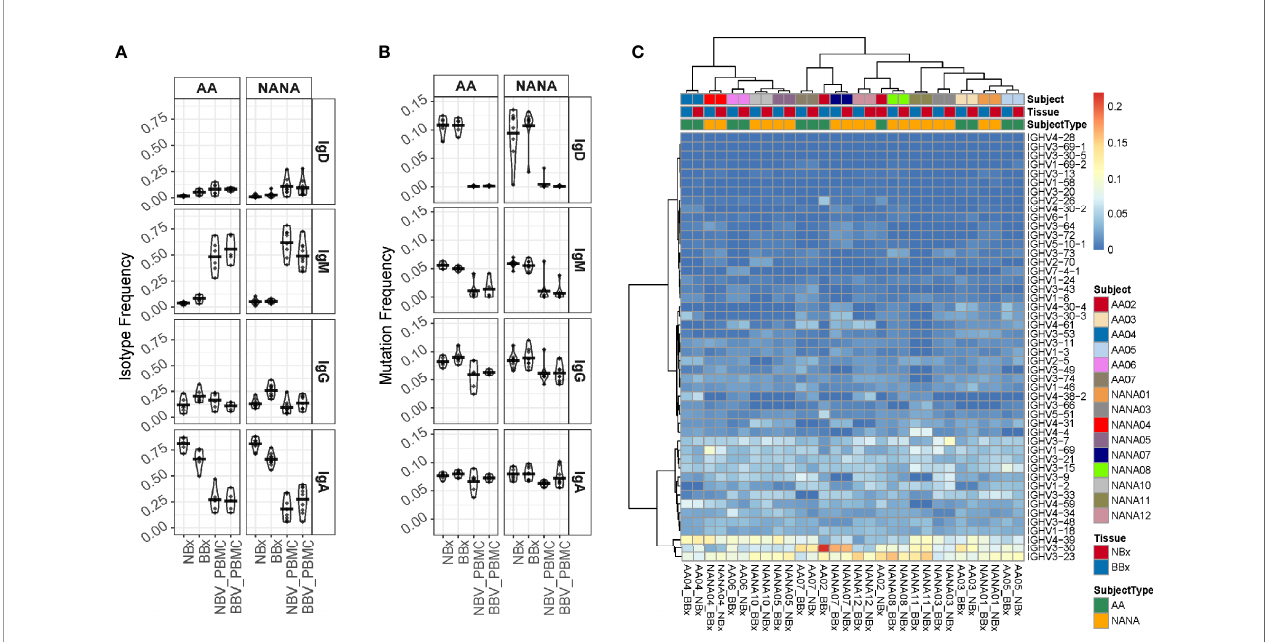
FIGURE 4 | Analysis of isotype frequencies, levels of somatic hypermutation (SHM) and IGHV-gene usage of Ig clones from the bronchial (BBx) and nasal mucosal biopsies (NBx) and peripheral blood mononuclear cells of the atopic asthmatics and non-atopic, controls. (A) Isotype frequencies in samples were calculated as fractions of the total sequences expressing a given isotype. Each dot represents an individual. (B) SHM frequencies were calculated for each sequence, then means calculated for all the clones of a given isotype and then for each isotype in each tissue type for each individual. Each dot represents an individual. (C) Heatmap showing the IGHV-gene usage frequencies in the bronchial and nasal mucosal biopsies from each